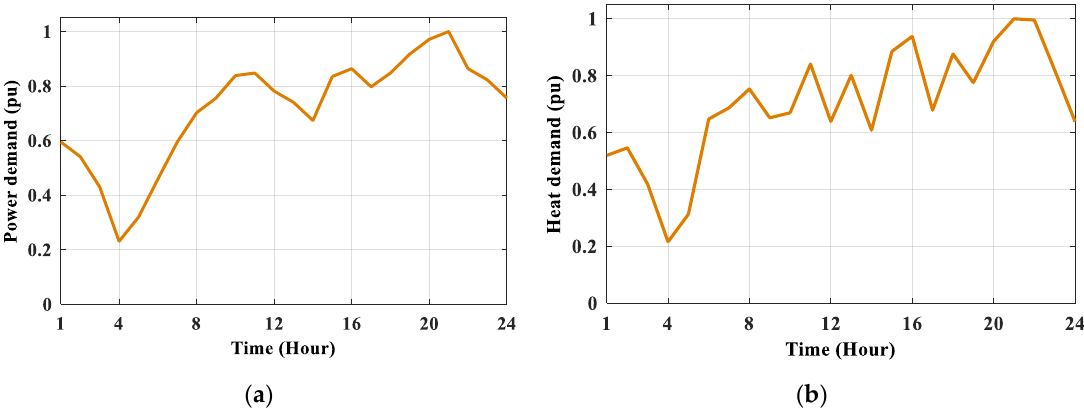
Figure 8. Short-term demands for generation scheduling. ( a ) Power demand; ( b ) heat demand.